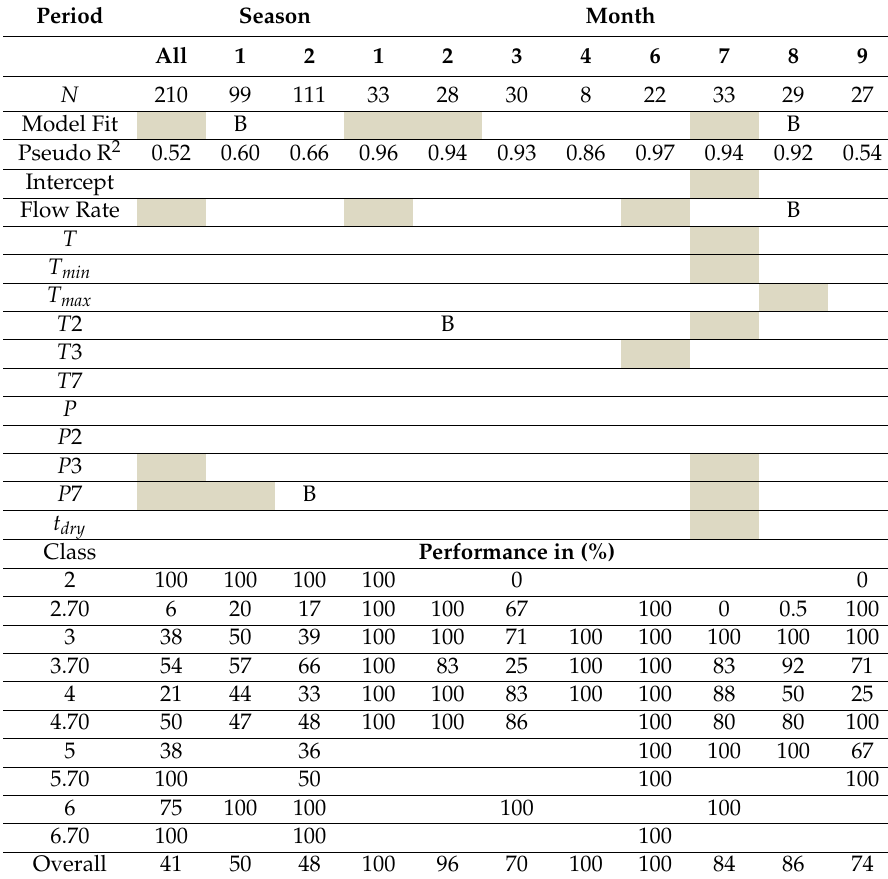
Table 5. MLR modelling results for Log FC i,j for the hotspot stations. A shaded box indicates a significant relationship with no shading indicating the p -value was greater than 0.05. The letter “B” indicates the relationship is not significant but the p -value was very close to 0.05.